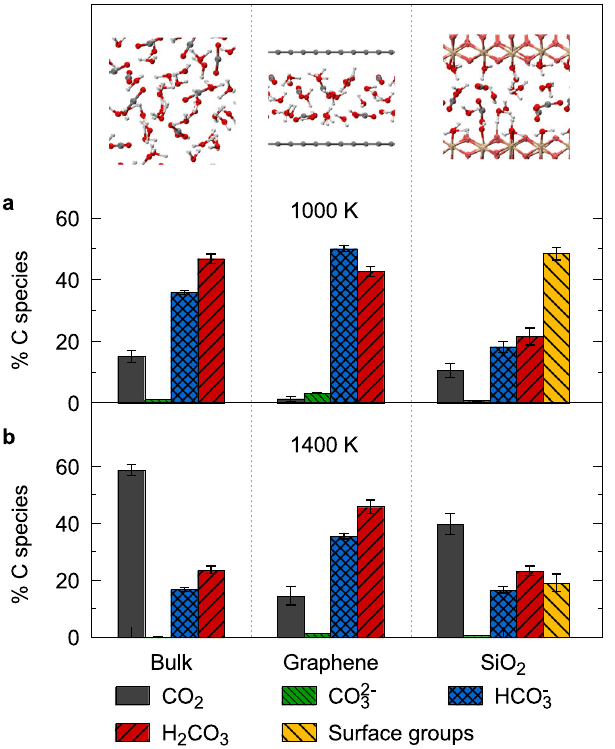
Fig. 2 | Mole percents of carbon species in the CO 2 (aq) solutions in bulk and nanocon fi ned by graphene and stishovite (SiO 2 ) at chemical equilibria. The initial molefraction ofCO 2 (aq) is 0.185.The pressureis~10GPa. The temperatures are a 1000Kand b 1400K.Thedataofbulksolutionsin( a )arefromref.10,andthe bulk data in ( b ) were interpolated using the simulation results in ref. 10. Uncer- tainties were obtained using the blocking method 68